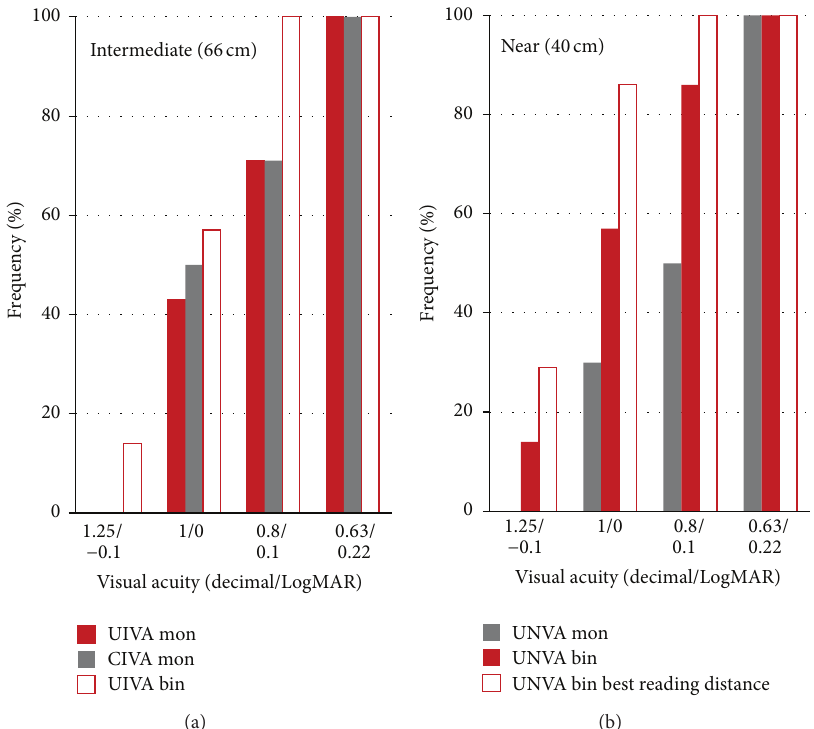
Figure 3: Postoperative intermediate (a) and near (b) visual outcomes at 3 months after surgery in the analysed sample.